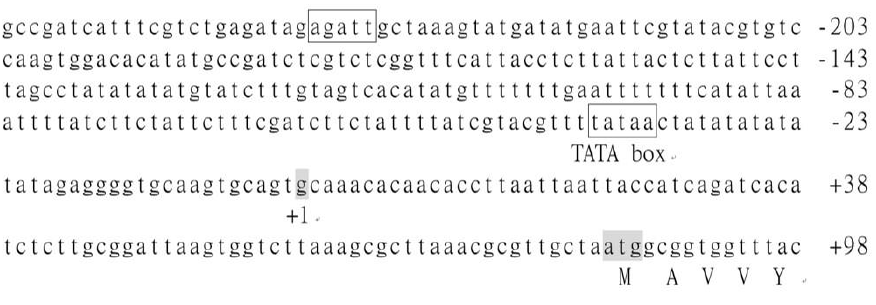
Figure 5. Promoter sequence analysis of the BoCKX1 gene. The start codon of translation (ATG) was shaded. The predicted transcriptional start site was indicated as “+1”. The putative functional TATA box and one NGATT element were indicated.